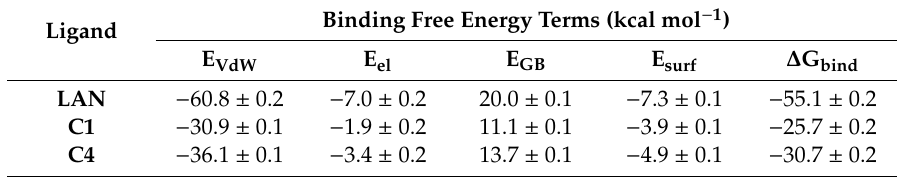
Table 4. MM / GBSA binding free energy estimates for the association of C1 , C4 and LAN to 14-alpha demethylase. Data was obtained from 1000 frames retrieved from the last 50 ns out of 150 ns